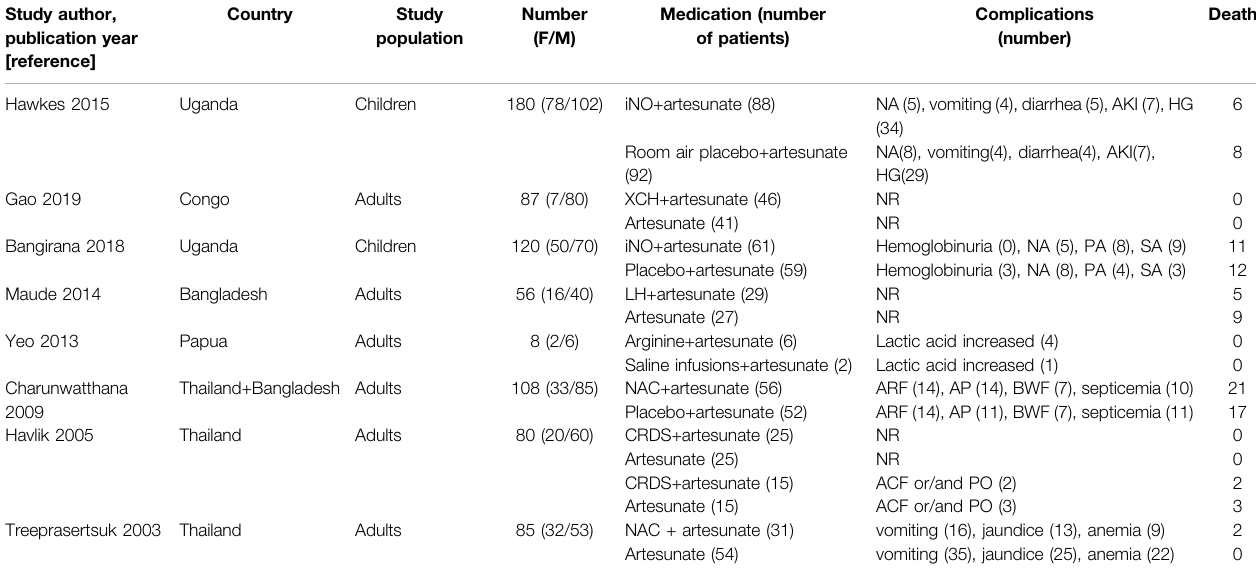
TABLE 1 | Characteristics of the included studies.